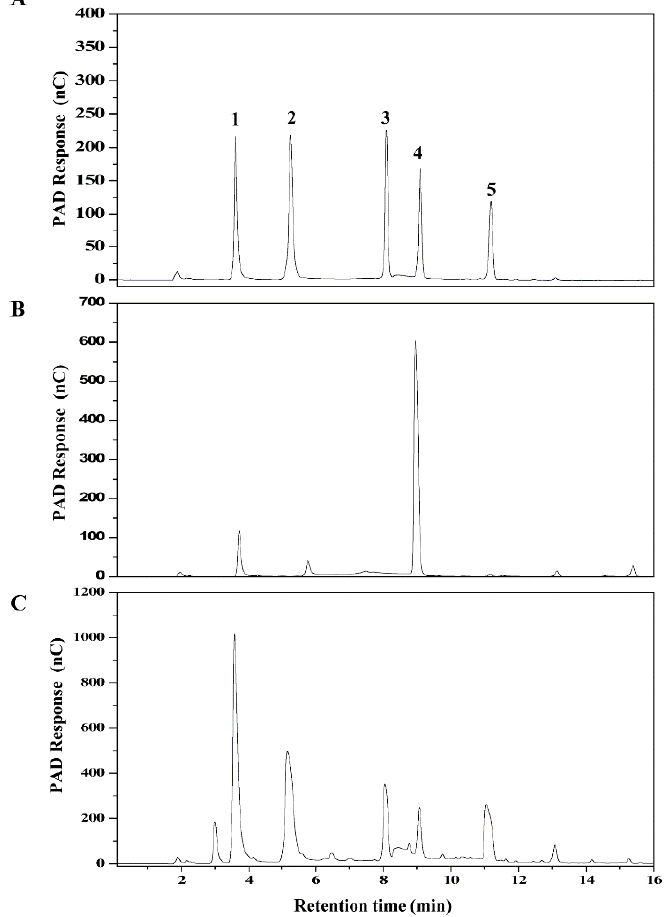
Figure 7. Identification of the transglycosylation products by HPAEC-PAD-200. ( A ) Standard samples of glucose (1), isomaltose (2), isomaltotriose (3), maltose (4) and panose (5). ( B ) maltose substrate (control group). ( C ) Transglycosylation products by recombinant GSJ.